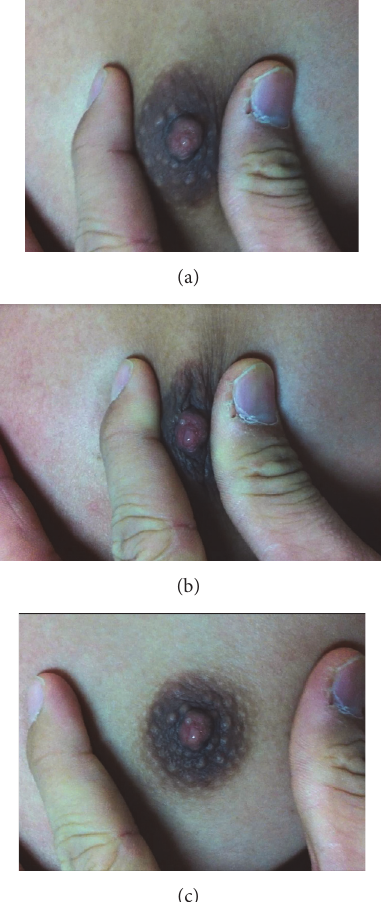
Figure 1: Galactorrhea. The pictures showed milky discharge from right breast, before (a), during (b), and after (c) gentle manipulation of the nipple.